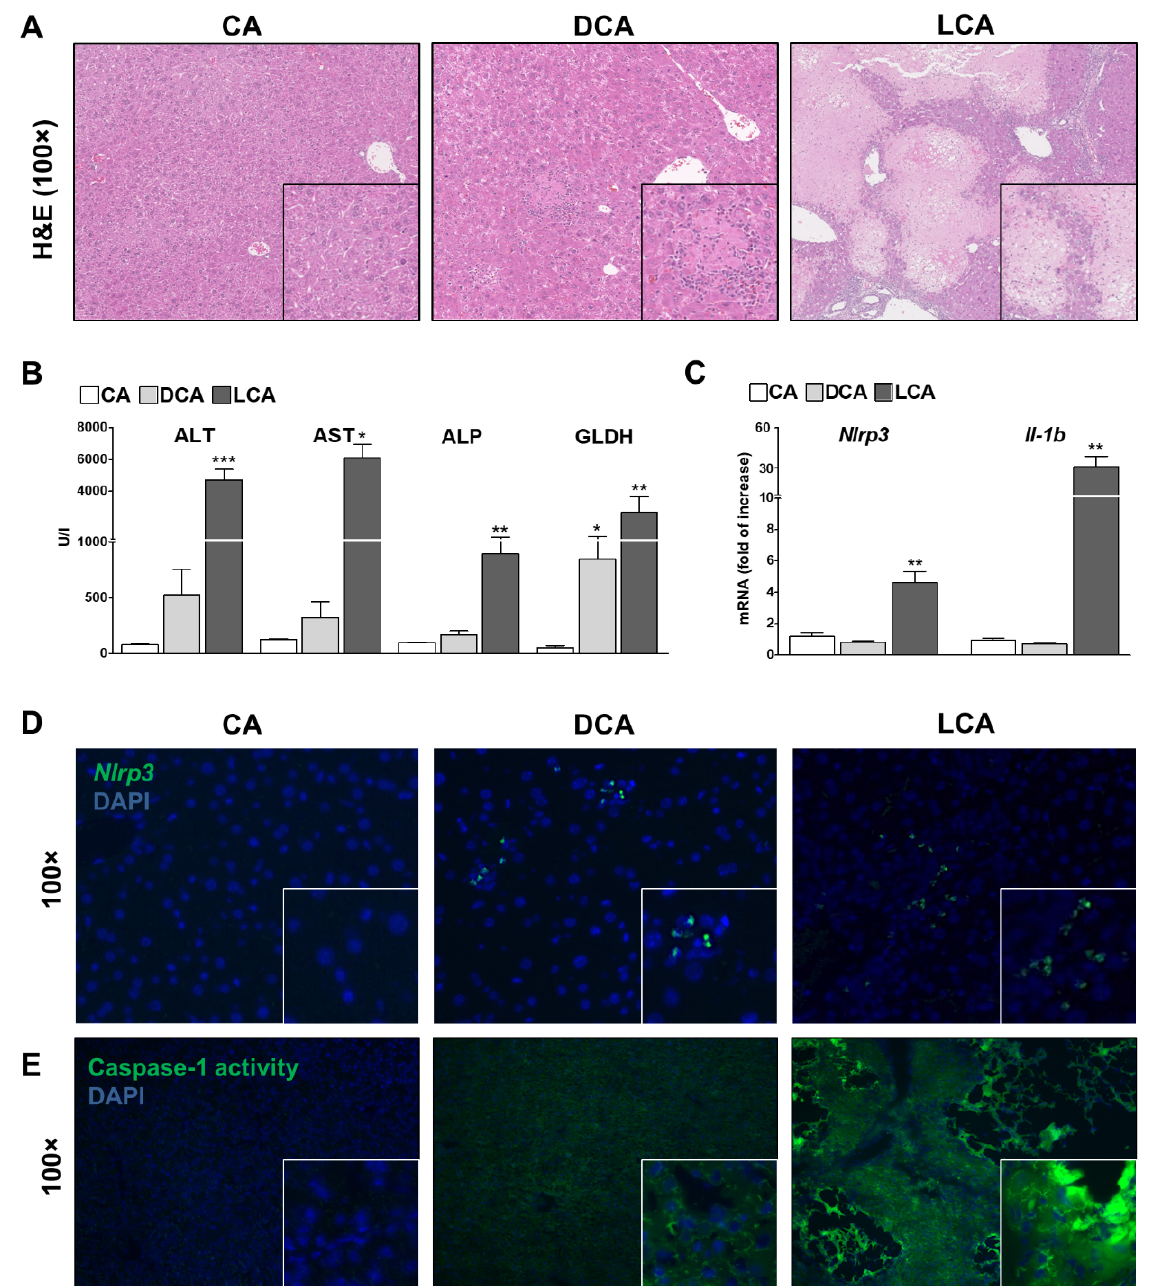
Figure 1. Feeding of DCA and LCA (0.5%) for seven days. H&E stainings reveal intermediate or severe liver damage in murine liver after feeding with DCA or LCA ( A ), confirmed by mildly or severely elevated levels of transaminases, ALP and GLDH ( B ). LCA feeding increased mRNA levels of Nlrp3 and Il-1b ( C ). FISH shows a punctual upregulation of Nlrp3 in DCA and LCA fed mice ( D ). Caspase-1 activity is mildly elevated after DCA feeding and strongly elevated after LCA feeding ( E ). CA feeding did not have any deleterious effects. * p < 0.05; ** p < 0.01; *** p < 0.001, n = 6.